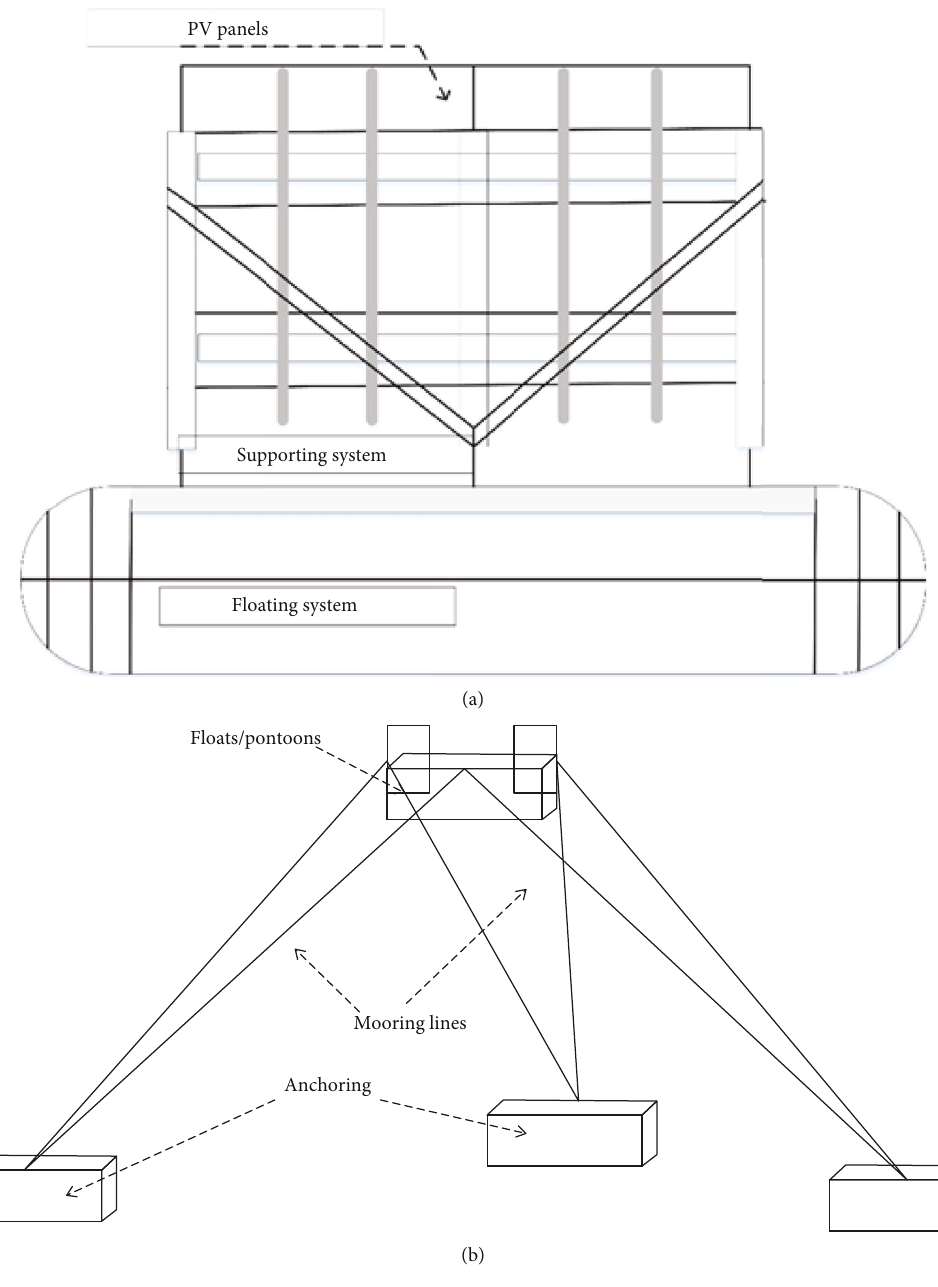
Figure 2: (a) Related mechanism for di ff erent photovoltaic systems on FPV module. (b) Mooring